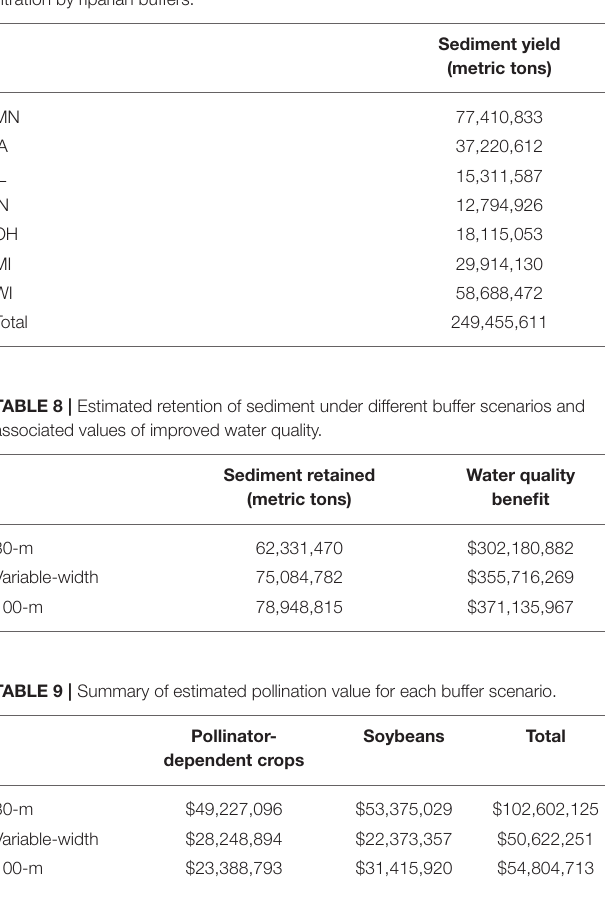
TABLE 7 | Estimated current annual production of sediment on lands subject to filtration by riparian buffers.